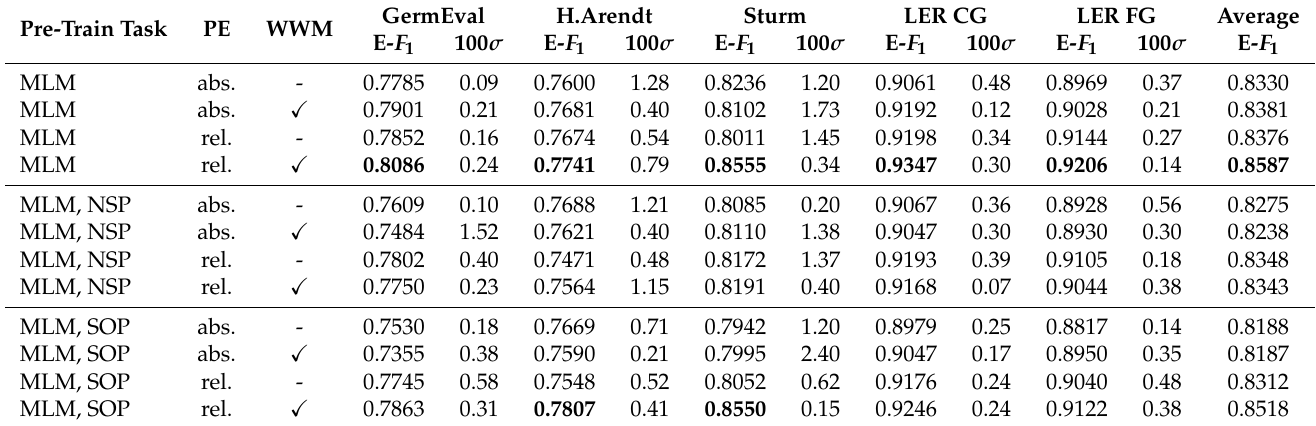
Table 6. Columns refer to the average E- F 1 score (cf. [24]) of three fine-tuning runs with Default-Fine-Tuning (see Section 4) for five datasets and its standard deviation σ multiplied by 100. Rows refer to the respective pre-training task, absolute or relative positional encoding (PE), and use of Whole-Word Masking (WWM); best results within 2 · σ of the maximum